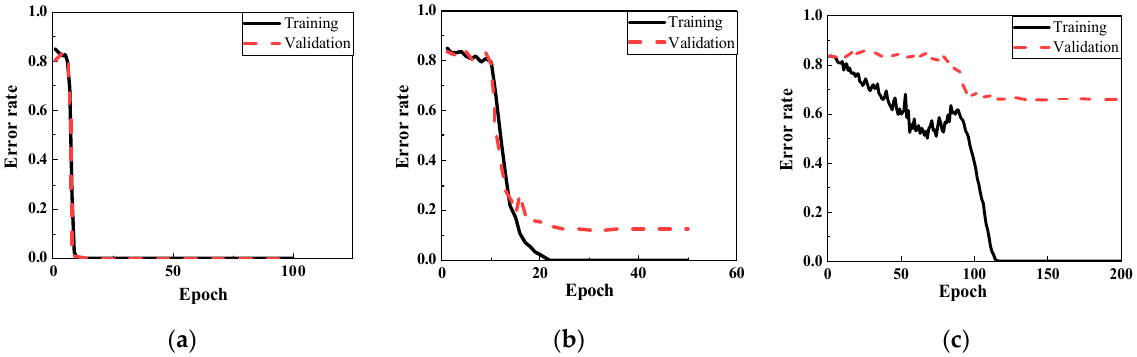
Figure 18. Training and validation results under noise of. ( a ) SNR = 80 dB; ( b ) SNR = 70 dB; ( c ) SNR = 60 dB.